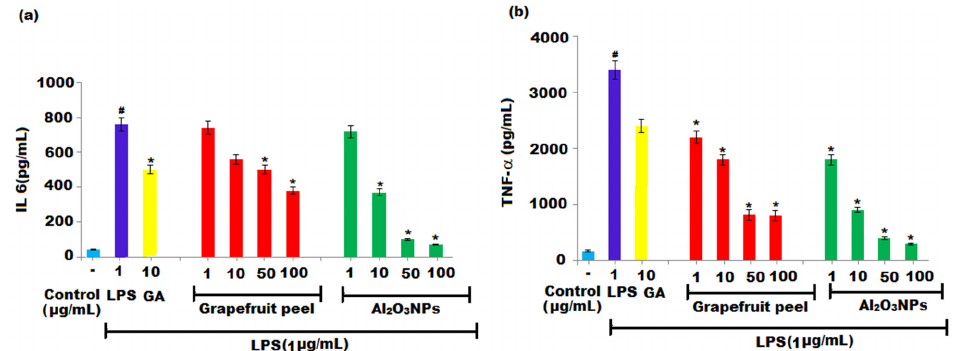
Figure 9. Effect of grapefruit peels extract and Al 2 O 3 NPs on the levels of ( a ) IL-6 and ( b ) TNF- α proinflammatory cytokines. RAW 264.7 macrophages were treated with varied concentrations of samples in the presence or absence of LPS. The # Significant ( p < 0.05) and * Significant ( p < 0.05) compared to the negative control without LPS and LPS-induced cells, respectively, by one-way ANOVA followed by Tukey’s post hoc test.